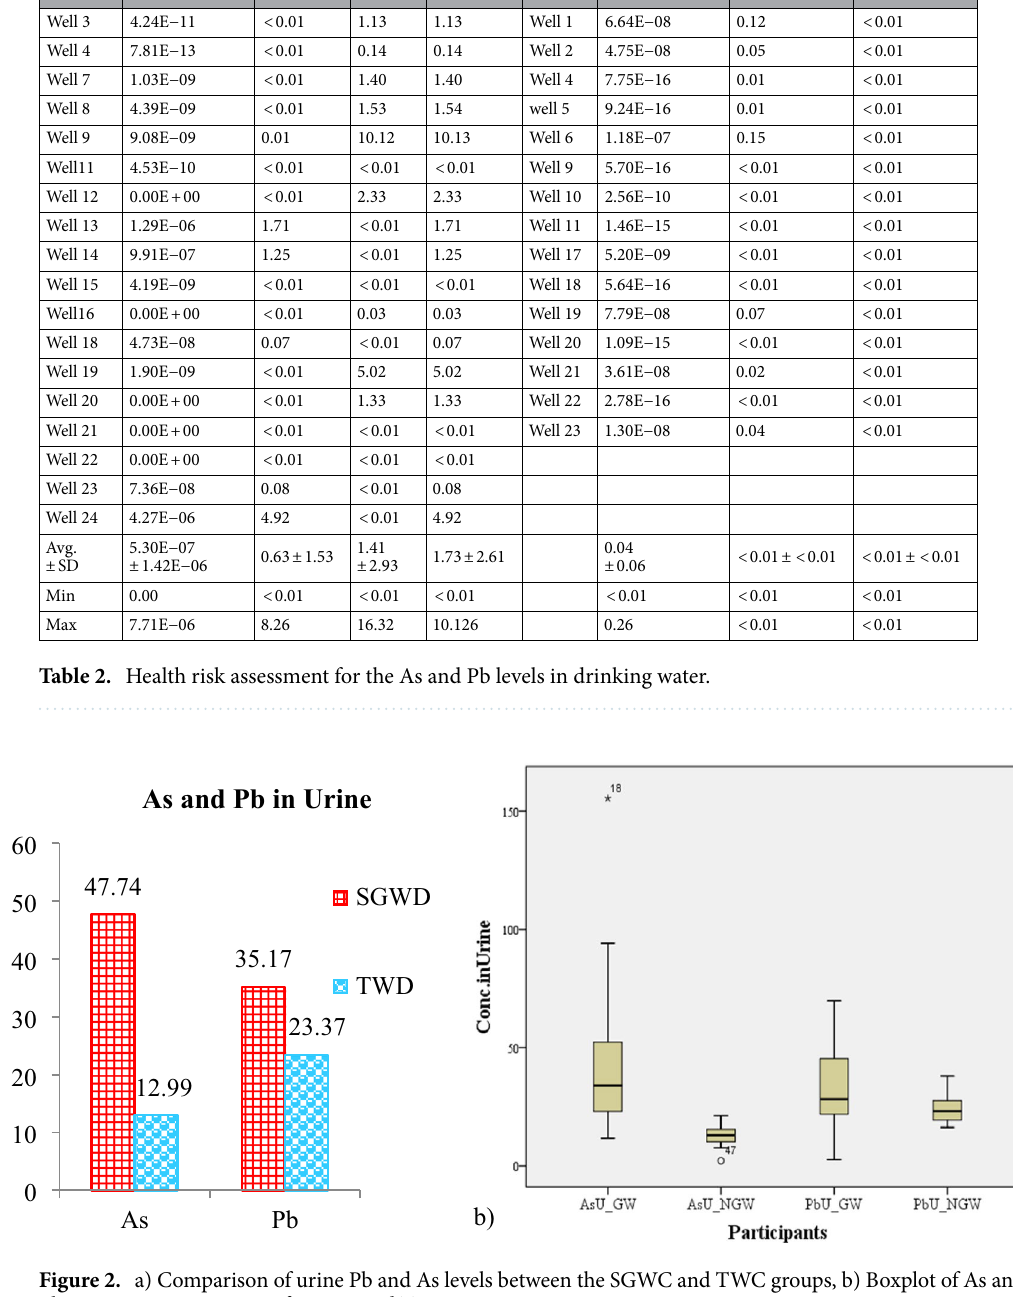
Figure 2. a) Comparison of urine Pb and As levels between the SGWC and TWC groups, b) Boxplot of As and Pb concentration in urine of SGWC and